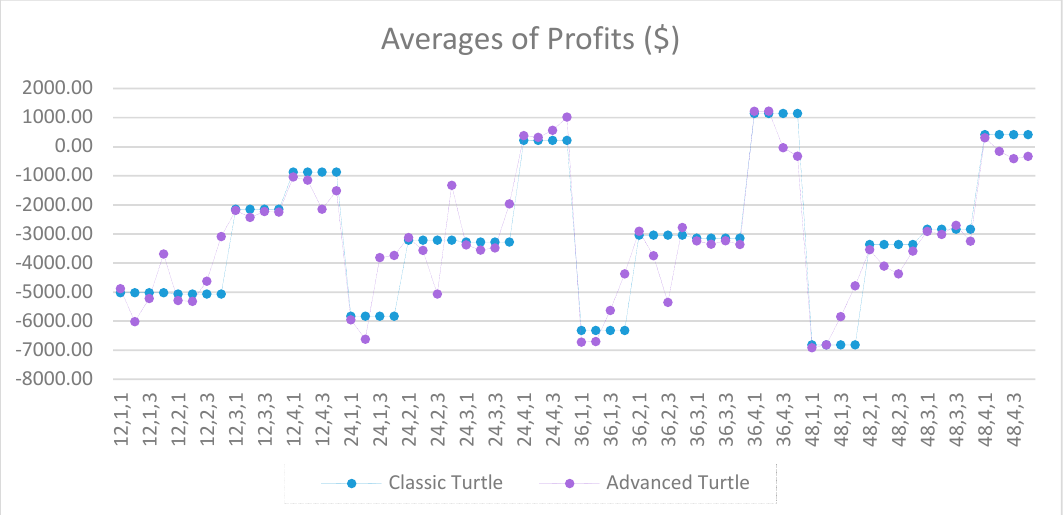
Figure 12. Averages of drawdowns as percentage of equity between the classic and the advanced Turtle systems for every combination of N, X, Y for the medium parameters (40, 80).